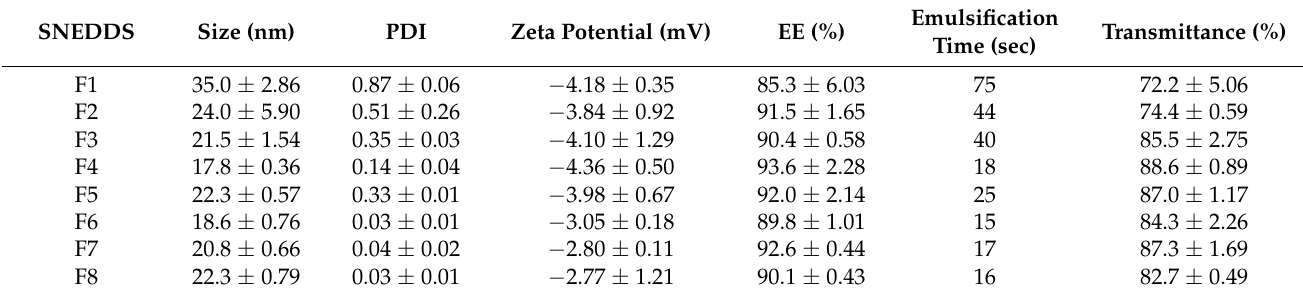
Table 3. Particle size, PDI, zeta potential, encapsulation efficiency (EE), self-emulsification time, and transmittance (%) of the drug-loaded SNEDDS (mean ± SD, n =